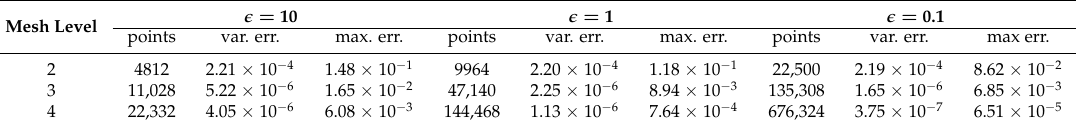
Table 1. Approximation investigation of f 1 . The error of variance (var. err.) and maximum error (max. err.) in 1000 randomly sampled points. = Mesh Level (cid:101)